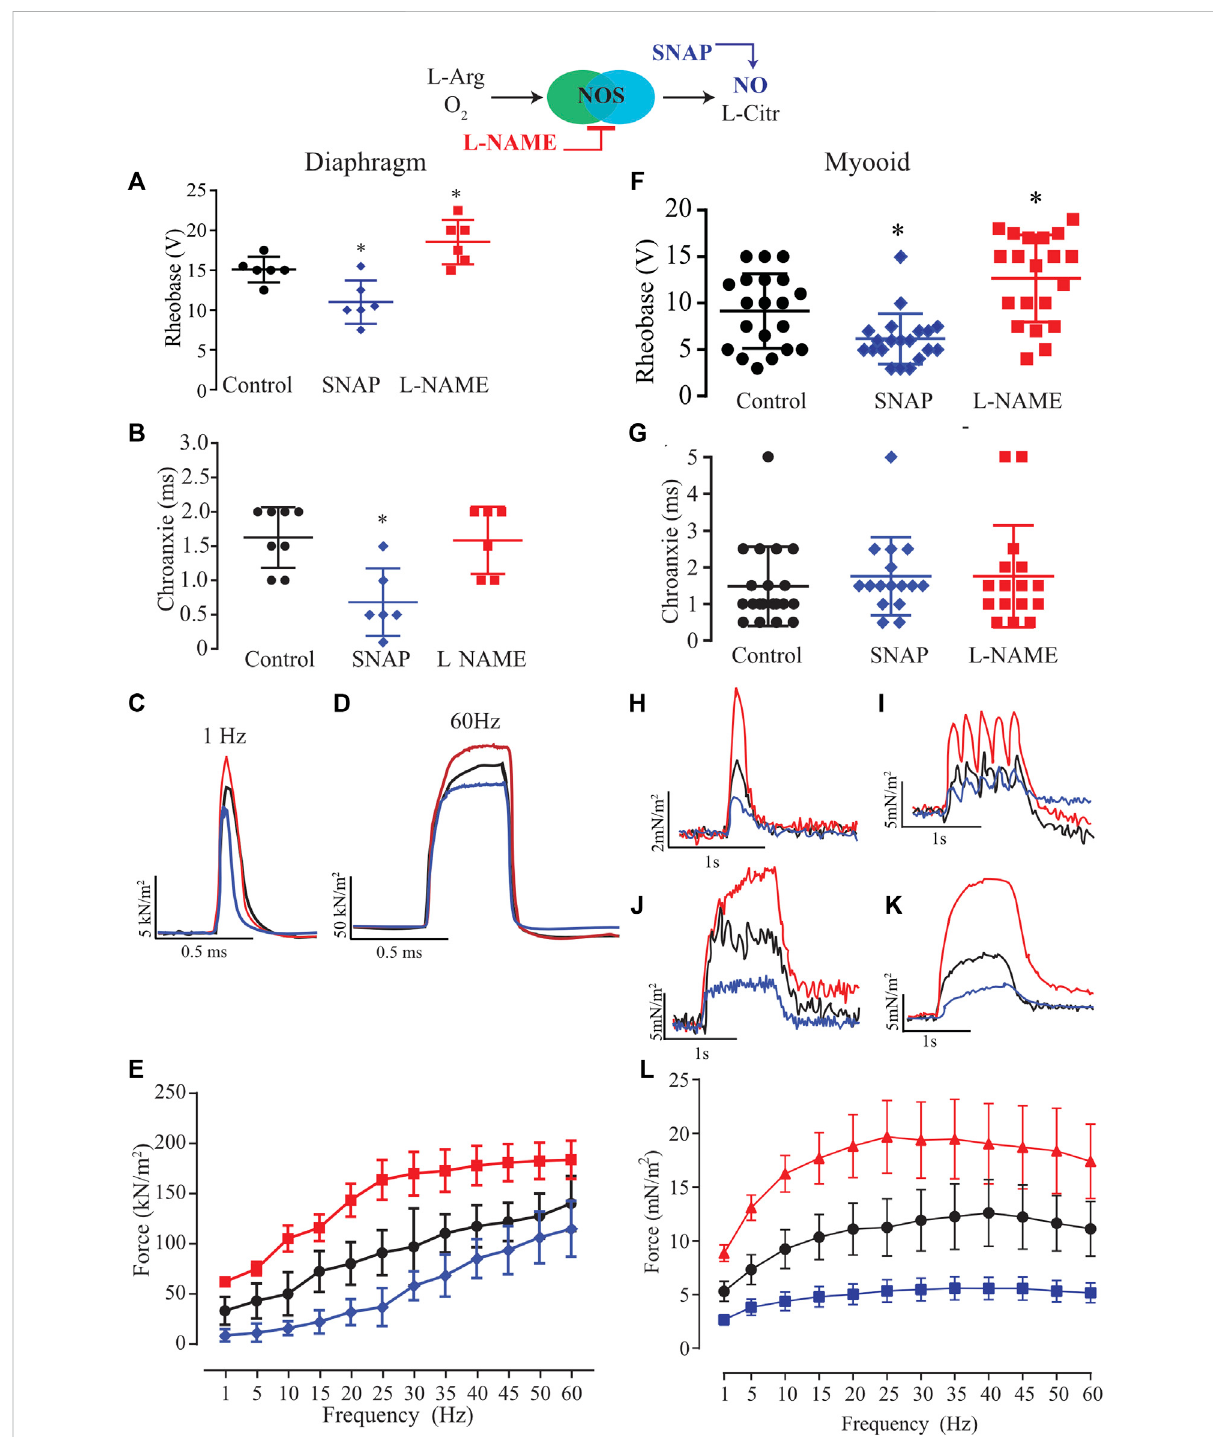
FIGURE 3 Summary analysis of the effect of exogenous NO and blocking endogenous production on excitability and force-frequency protocol for six diaphragm strips (A – E) and twenty myooids per condition (F – L) . The response under theeffect of 100 µM of SNAP is representedby theblue linesand 5 mM of L-NAME by the red color. (A,F) Rheobase response corresponds to the minimal voltage at 100 ms of stimulation for six diaphragm strips per condition. (B,G) Chronaxie response corresponds to minimal stimulation duration at double of rheobase for six diaphragm strips and twenty myooids. (C,D,H,I,J,K) Representativetracesofforceproductioninresponseto electrical stimulation(50 V,20 ms)under theeffectsofSNAP(blue)and L-NAME(red)recordedfromdiaphragmstrips (C,D) andmyooids (H – K) . (C,H) representtheresponseto1 Hzofstimulation, (I) for5 Hz,Jfor20 Hz,Kfor 35 Hz,and (D) for60 Hz. (E,L) summarizetheforceproductioninresponsetoincrementsinfrequencyofstimulation,from1upto60 Hzfordiaphragm strips and myooids, respectively. Statistical comparison is against the control (black) and * represents the threshold of signi fi cance set at less than